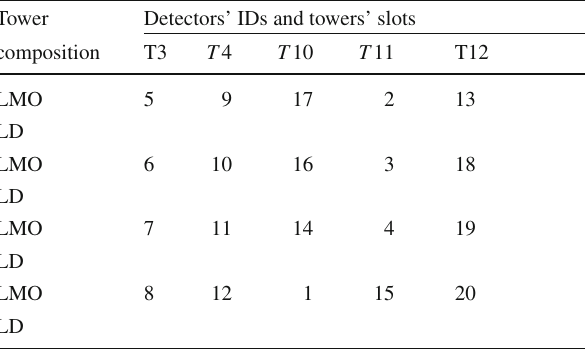
Table 1 CUPID-Mo tower compositions and their corresponding slots inside the EDELWEISS set-up at LSM